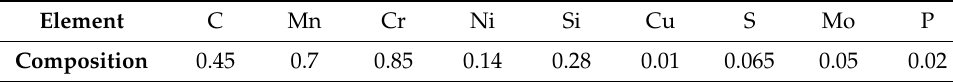
Table 1. Chemical composition of the material [4,36–39]. Element C Mn